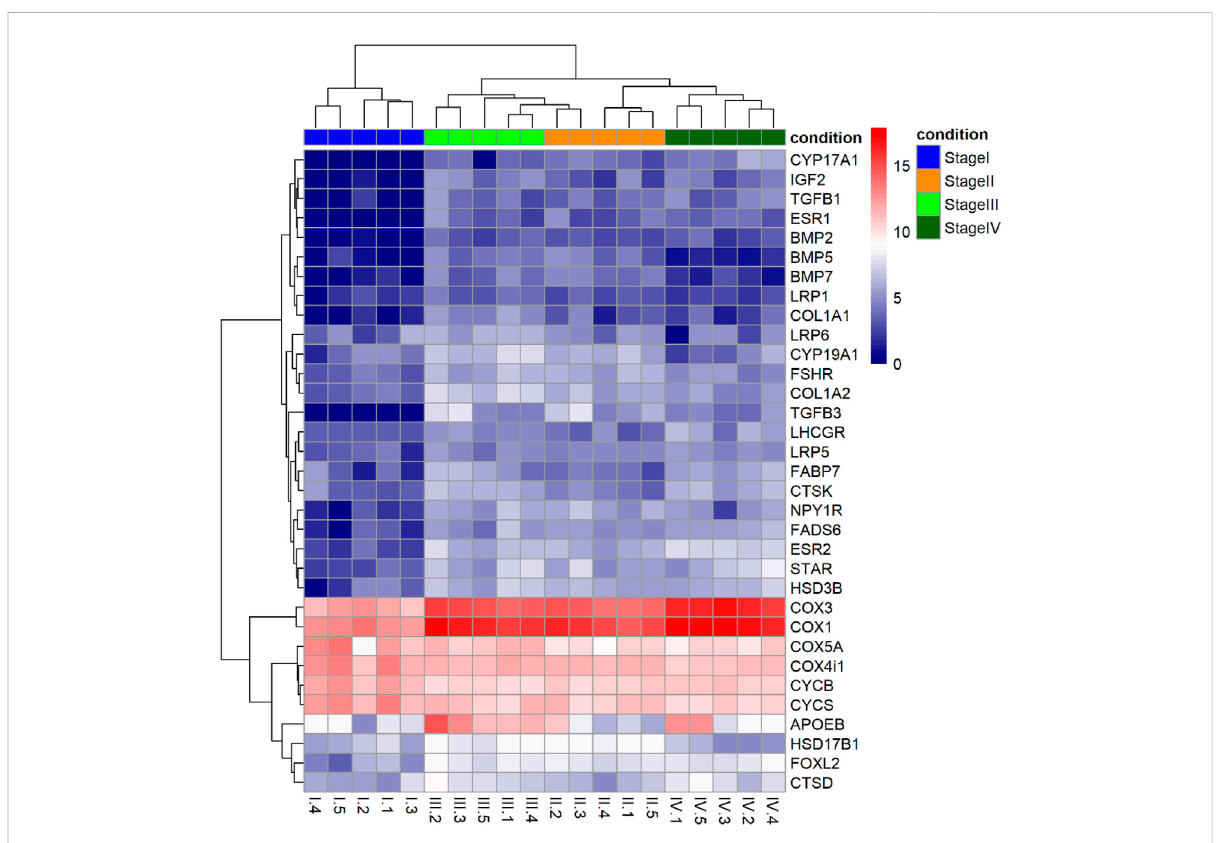
FIGURE 4 Heatmap ofLog2foldchangesofasetofgenesselecteddue to theirknown roleinprocessesrelated to vitellogenesis suchas steroidogenesis, lipidmetabolismandtransport,andenergyproduction.Eachcolumnrepresentssamplesandallsamplesweredivided totwoclustersbasedontheir stage (previtellogenesis and vitellogenesis). Hierarchical clustering for the gene expression matrix was based on the Euclidean correlation. The gradual colour from blue to red represents the expression changes of